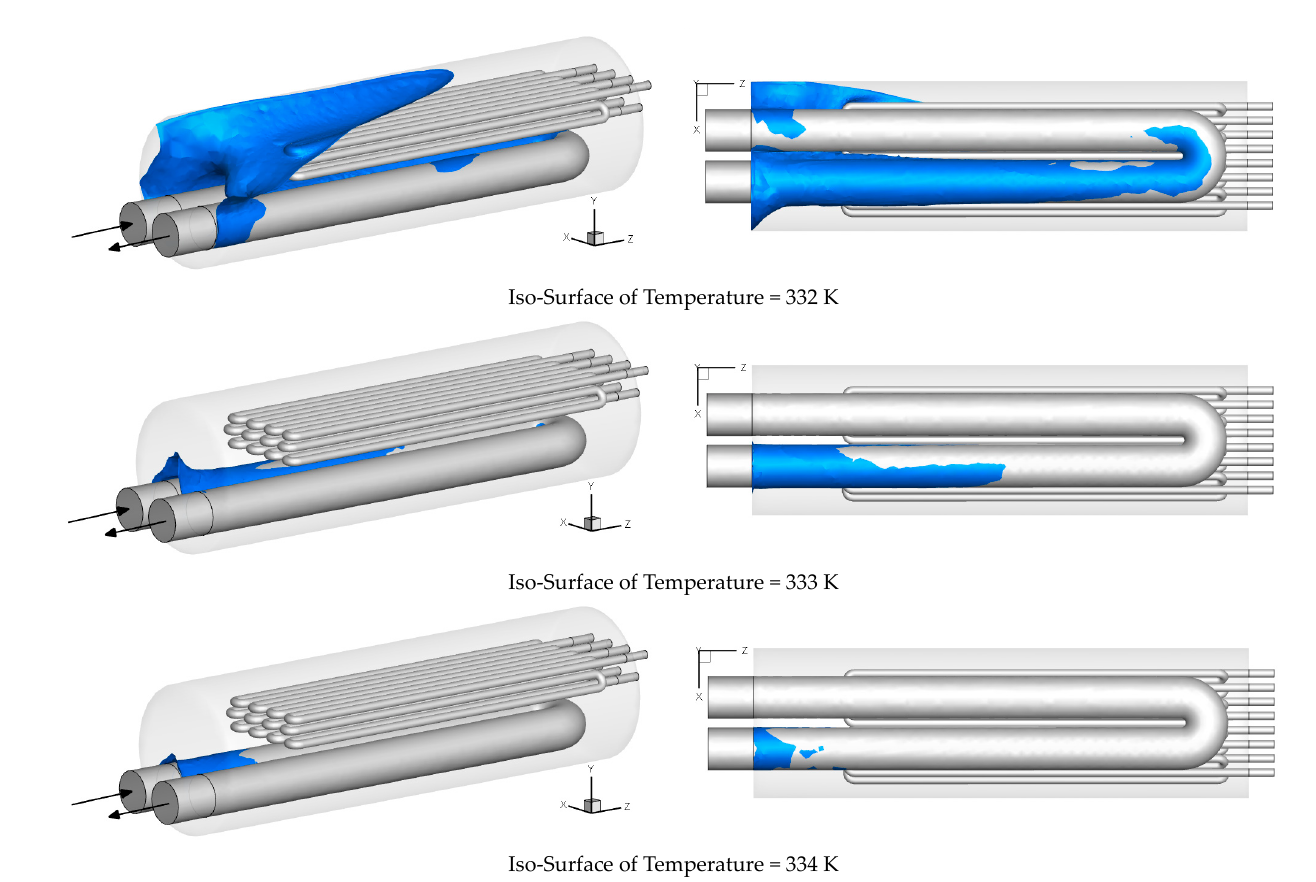
Figure 18. The iso ‐ surfaces at various temperatures inside the water tank of the considered heater. Figure 18. The iso-surfaces at various temperatures inside the water tank of the considered